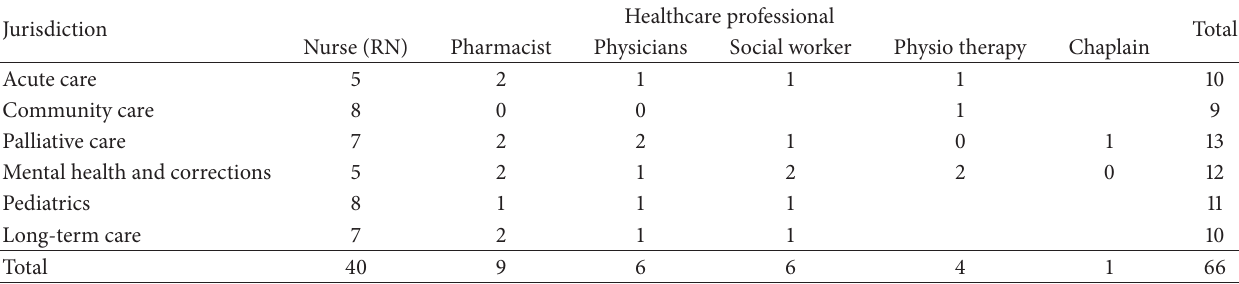
Table 1: Participant distribution by healthcare profession and